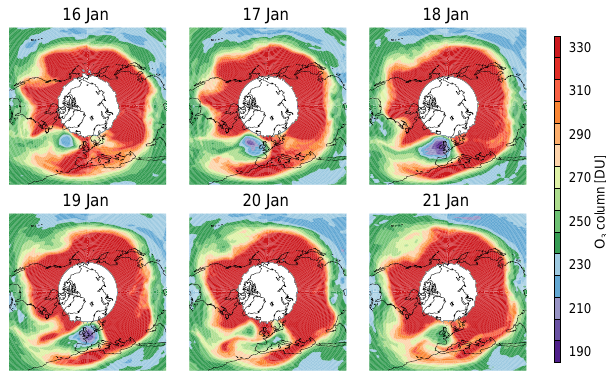
Figure 1. OMI total ozone column for 16–21 January 2006. The data over the pole are missing due to the lack of UV backscattering. Red/purple indicate relatively high/low values of OMI total ozone